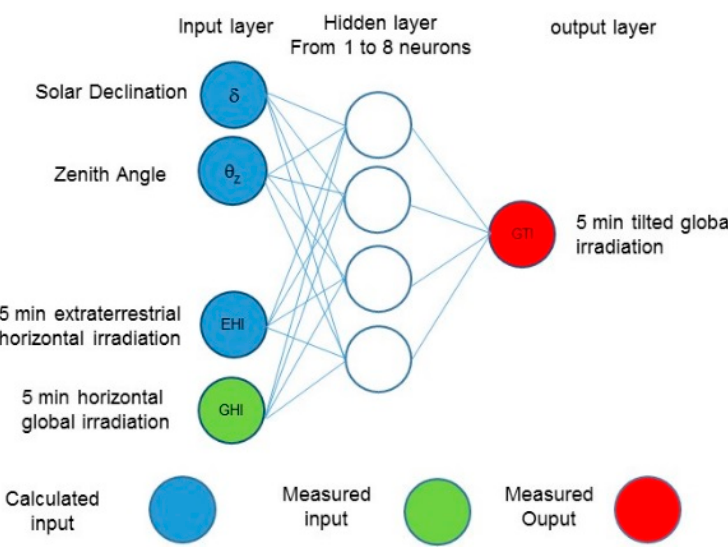
Figure 6. ANN architectures for the estimation of ETI.